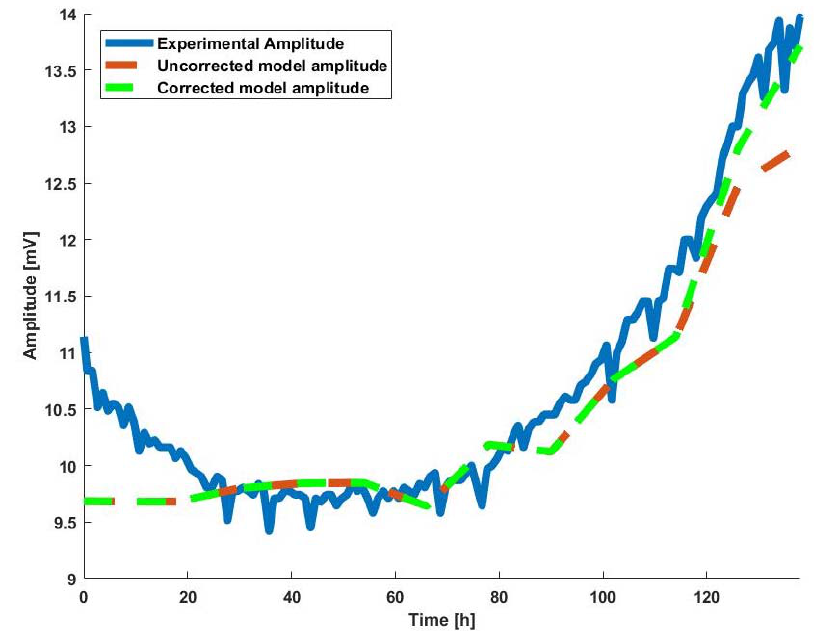
Figure 2. Comparison between the experimental amplitude, the amplitude of the uncorrected R s electric model, and the amplitude of the R s -corrected electric model.